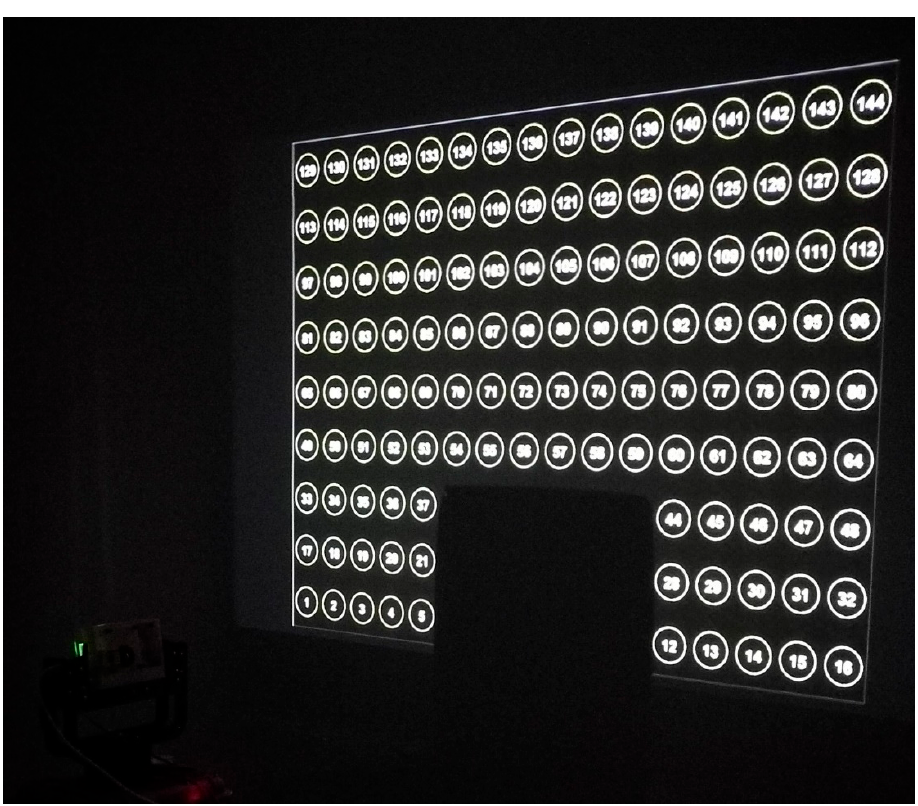
Figure 4. Experiment setup for the FSS calibration.